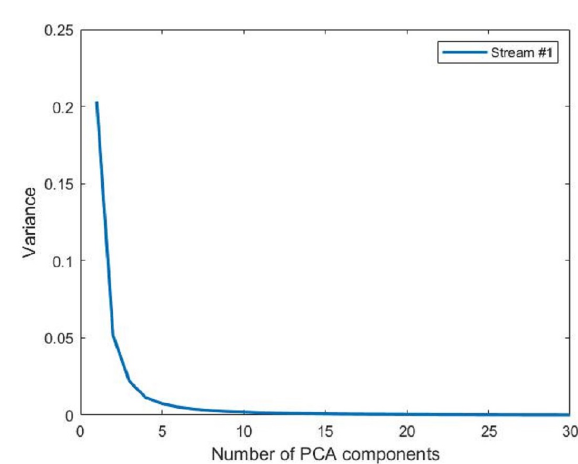
Figure 11. The variance in each PCA